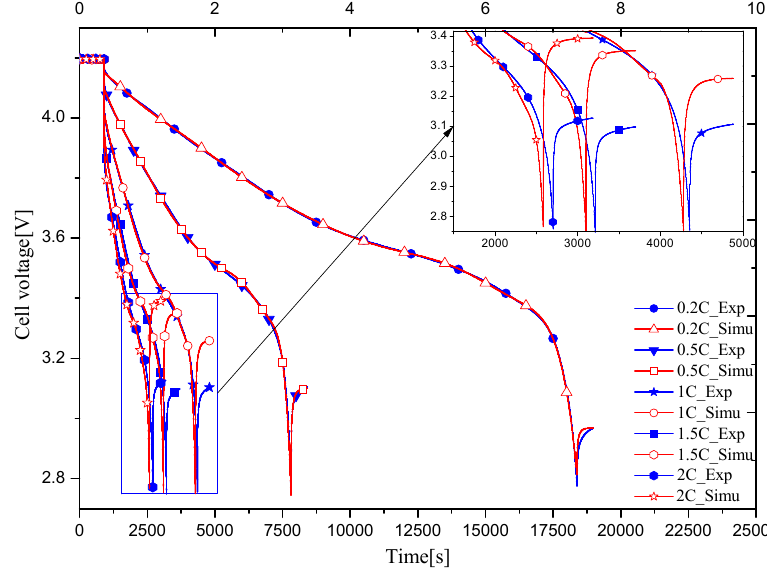
Figure 10. Comparison of experiment and Simulation of 0.2 C to 2 C discharge.